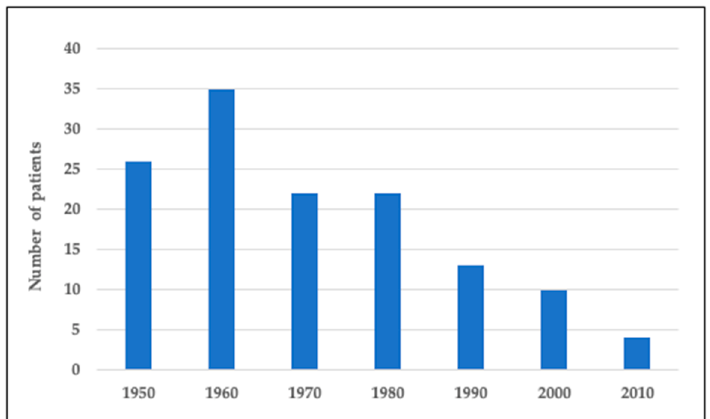
Figure 1. Number of individuals with DTD in Finland born in 1950–2020.